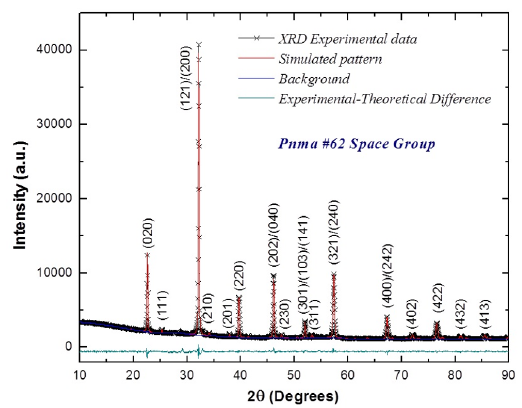
Figure 1. Comparison between the refined XRD data and the simulated pattern for the LaBiFe